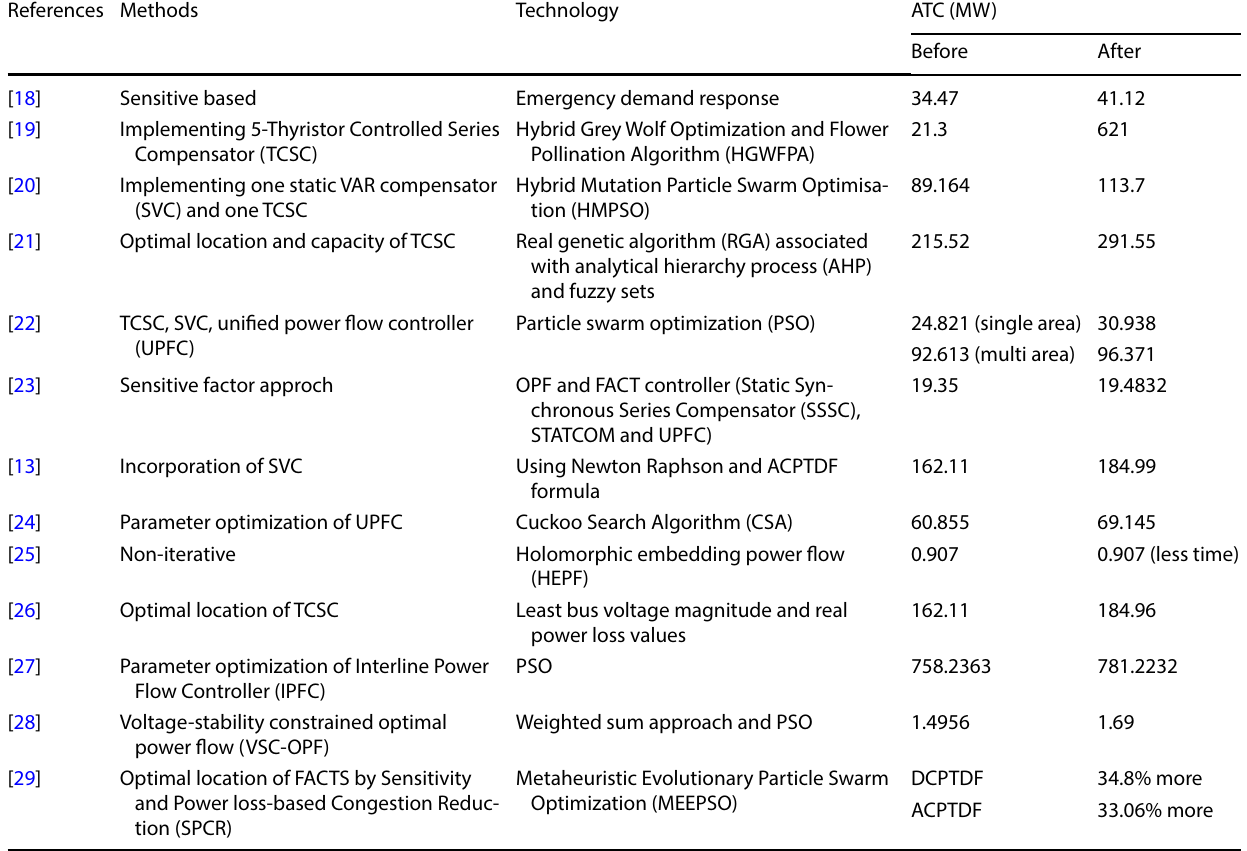
Table 1 Comparison of ATC enhancement method and technology used for IEEE-30